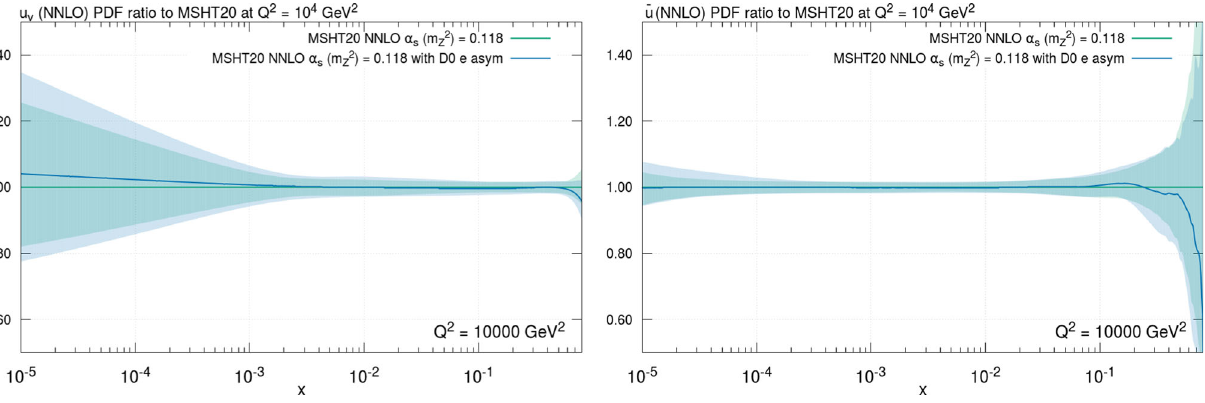
Fig. 58 (Left) u V PDF and (right) ¯ u PDF ratios to the MSHT20 default at Q 2 = 10 4 GeV 2 at NNLO showing the effect of including the DØ data as an electron asymmetry rather than the W